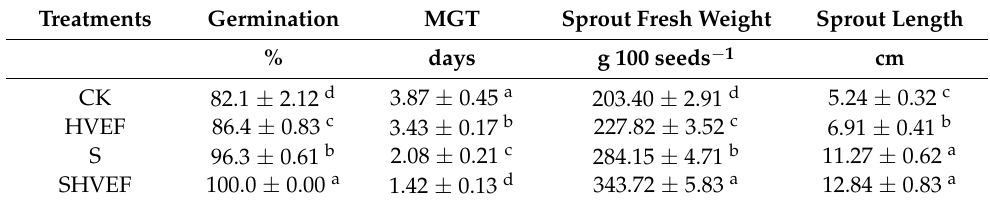
Table 1. Effects of different treatments (CK, control; HVEF, high-voltage electric field; S, soaking; SHVEF, soaking + highvoltage electric field) on the germination percentage, mean germination time, sprout fresh weight, and sprout length of 6-day-old adzuki bean sprouts.